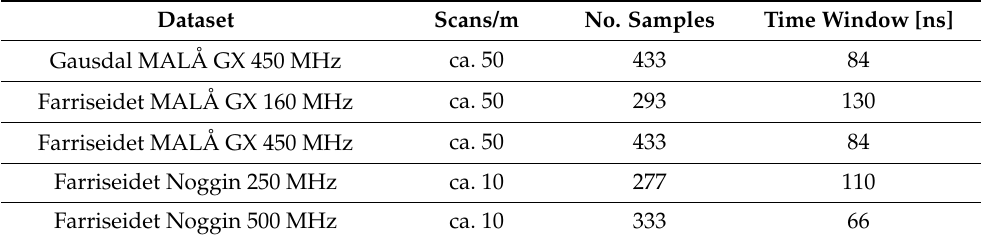
Figure 1. Setup of the GPR system for survey on wetland at Gausdal: The GPR antenna and RTK-GNSS receiver are placed in a sled, which is towered over the uneven, wet terrain. The GPR control unit and a tablet computer for navigation is carried in front of the operator. Image: Manuel Gabler, NIKU. Table 1. Systems and acquisition parameters used for the data